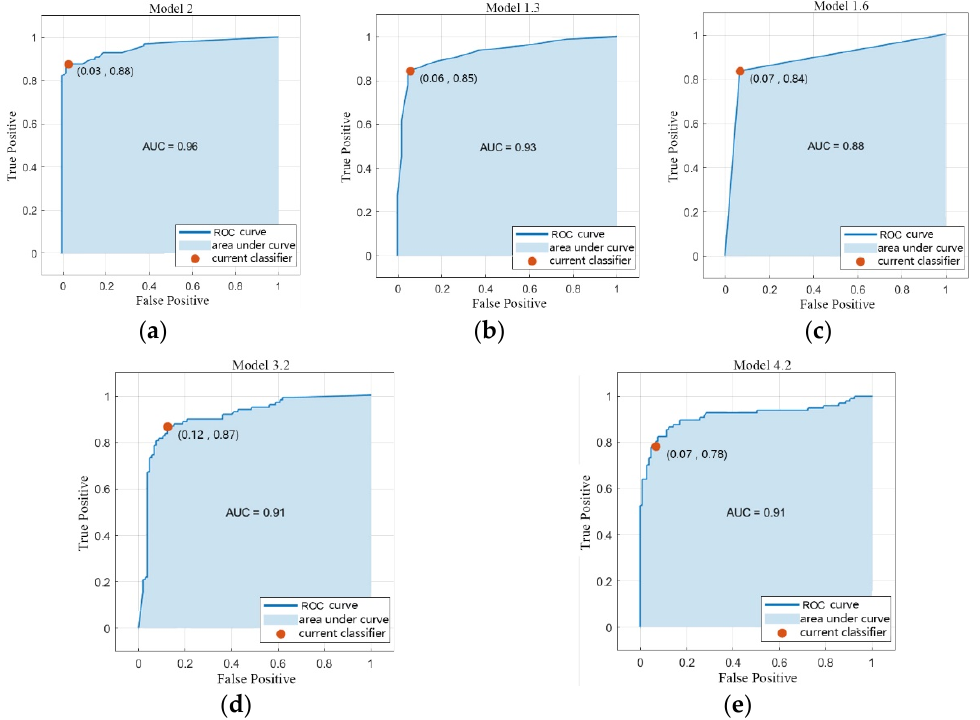
Figure 11. AUC for Bagging, Decision Tree, KNN, Naive Bayesian, SVM ( a ) Bagging ( b ) Decision